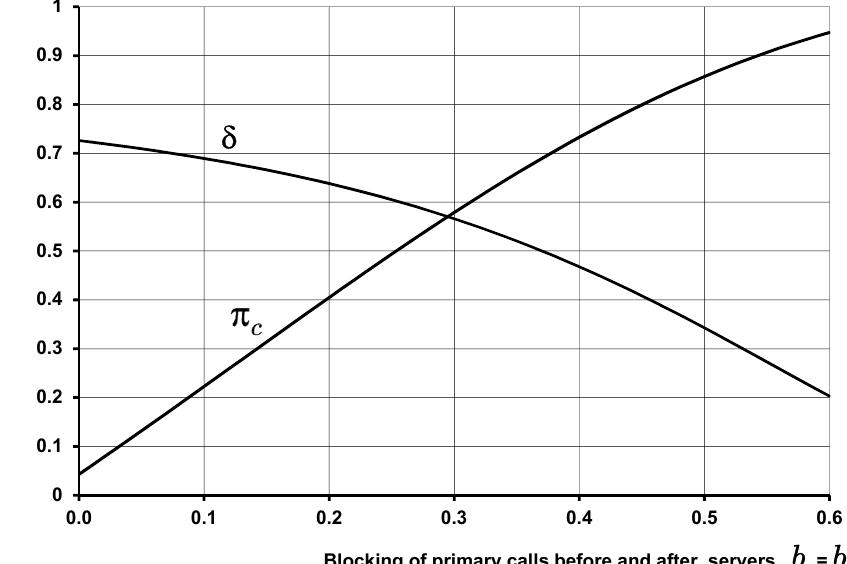
Figure 4. Dependence of π c and δ on b p , b r , a p and a r